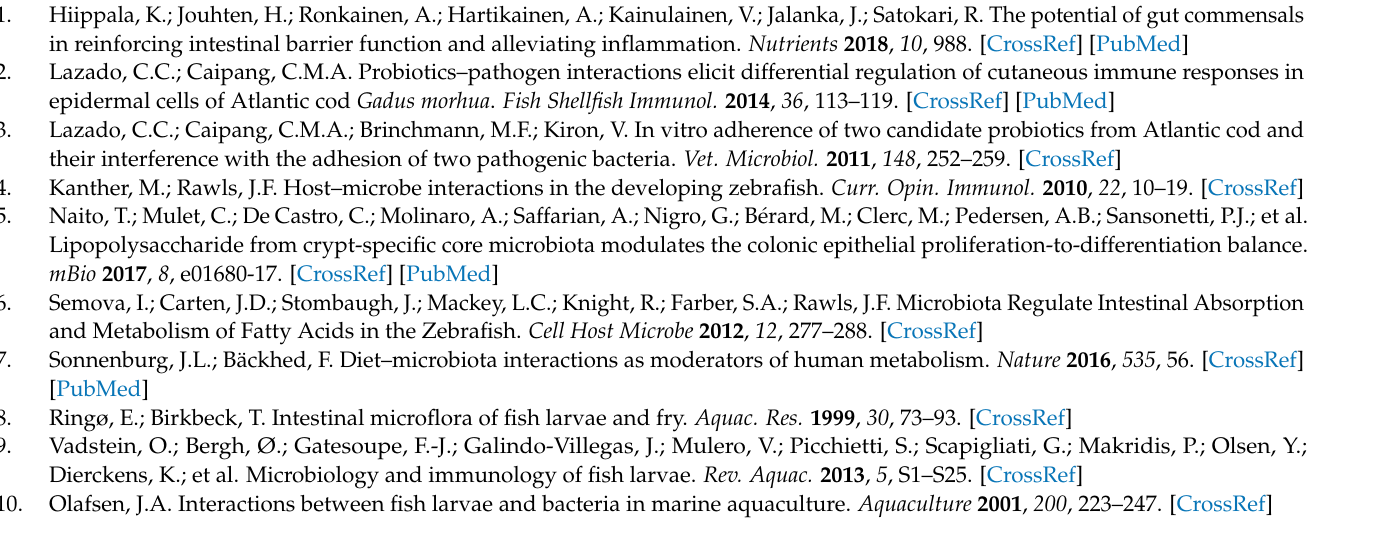
of cod larvae, Figure S3: DGGE gel, Figure S4: Venn diagram, Table S1: List of down-regulated genes (cut-off value of log2 fold change > 0.8) in conventional cod larvae compared with germ-free cod larvae at 16 dph. Table S2: List of up-regulated genes (cut-off value of log2 fold change > 0.8) in conventional cod larvae compared with germ-free cod larvae at 16 dph. Table S3: List of down- regulated genes (cut-off value of log2 fold change > 0.8) in gnotobiotic cod larvae compared with germ-free cod larvae at 16 dph. Table S4: Enriched GO terms in conventional larvae compared with both germ-free and gnotobiotic cod larvae. Table S5: Taxonomy and most similar “type strains” for the six OTUs classified as Vibrio as inferred from the Ribosomal Database Project (RDP). Text S1: Verification of germ-free conditions, Text S2: Live feed and bacterial cultures, Text S3: Sampling procedures, Text S4: Statistical